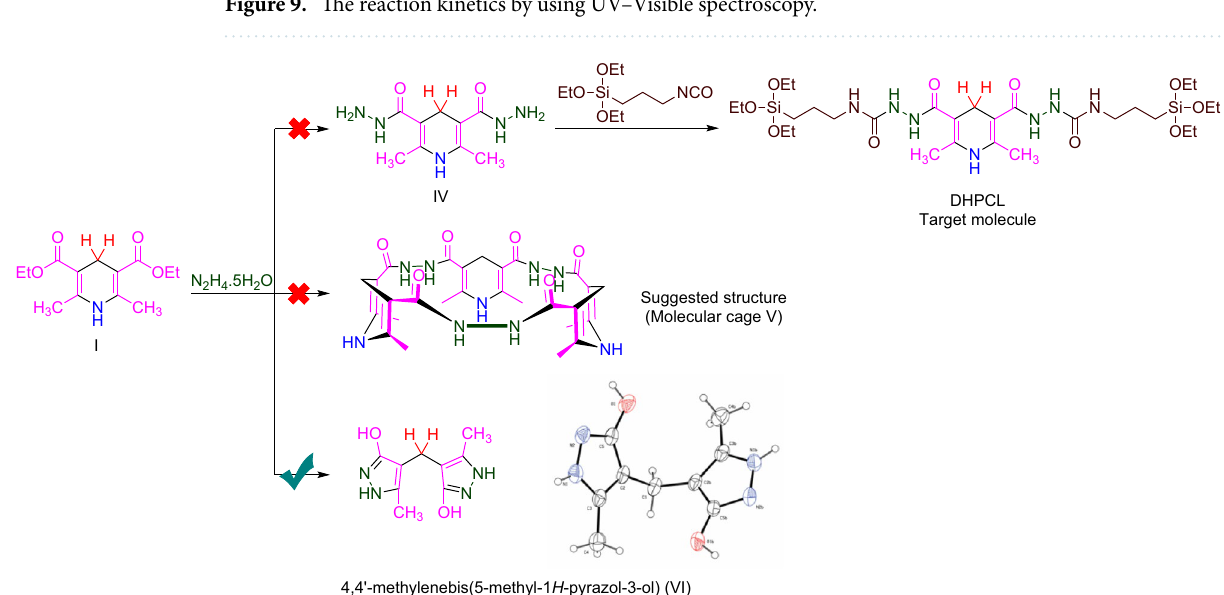
Figure 9. The reaction kinetics by using UV–Visible spectroscopy.